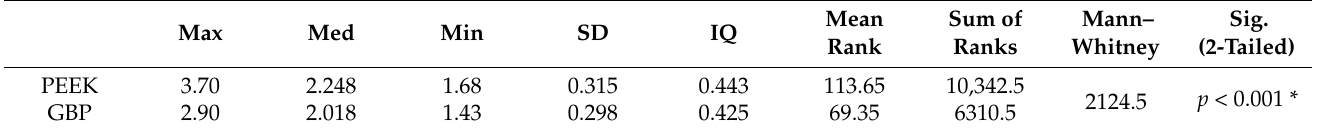
Figure 2. Plot showing the mean and standard deviation of the pull-off force in Newtons (N) of the studied materials at the selected steps of removal cycles. The blue diamond symbol with a continuous line represents the PEEK clasps and the orange circle symbol with a dotted line represents the GBP clasps. Table 2. Descriptive statistical analysis and significant difference between the studied materials represented in Newtons (N).